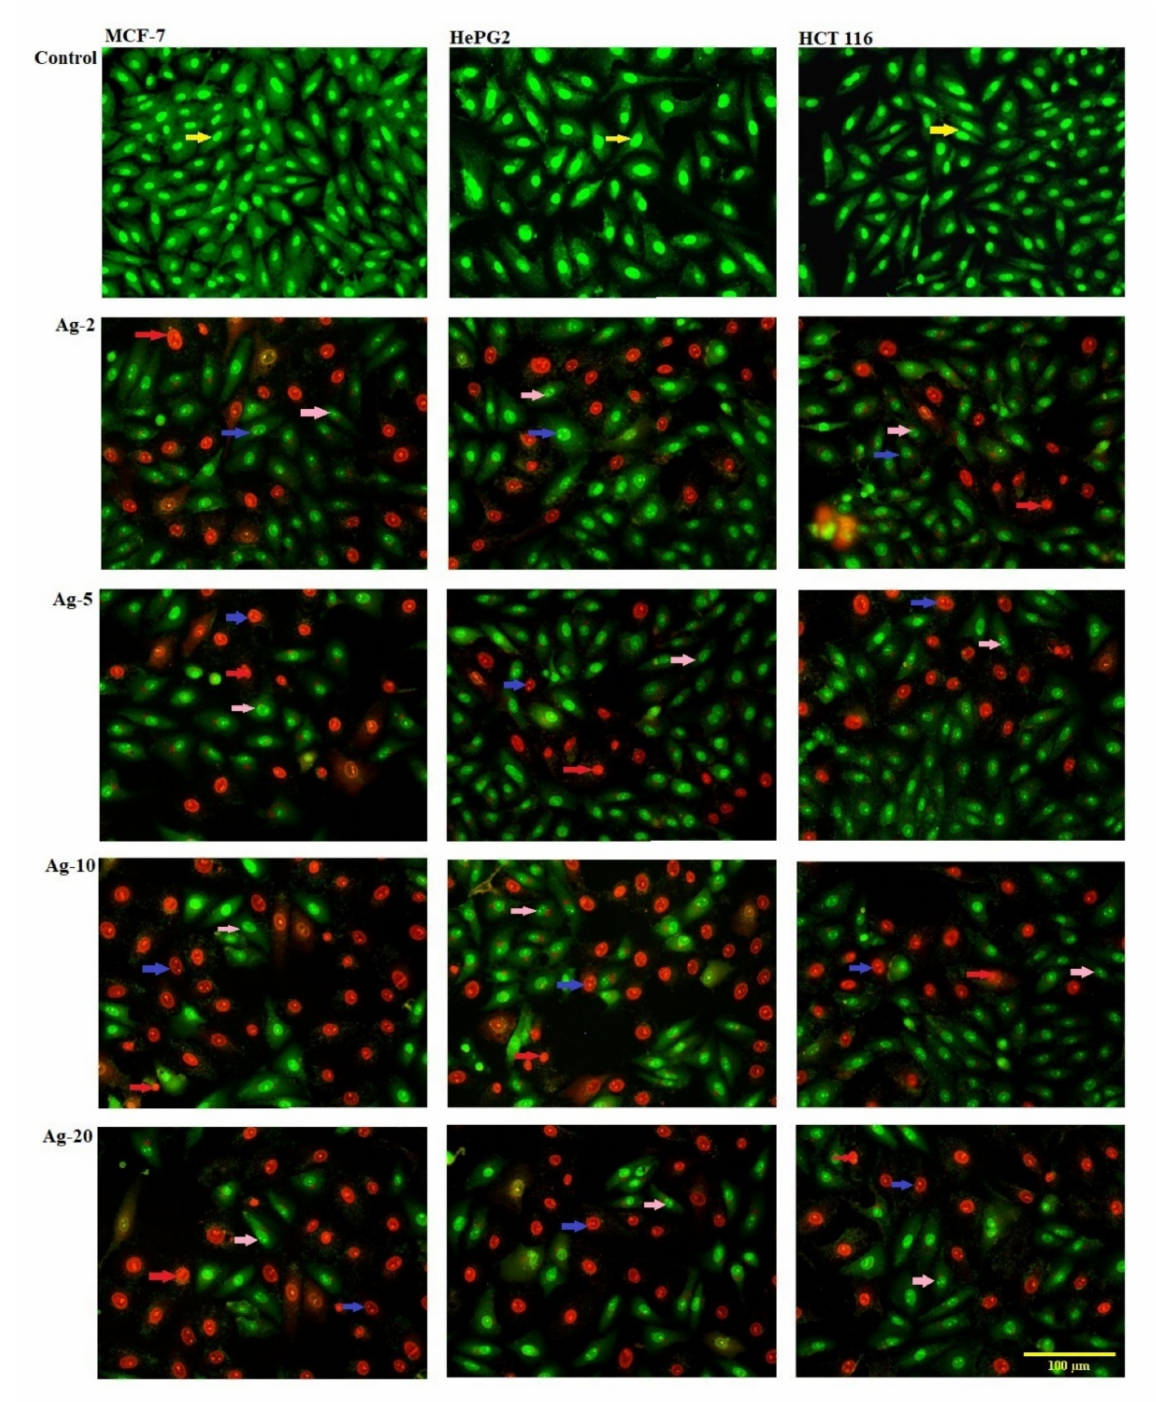
Figure 8. The effect of nanosilver compounds treatment on the apoptosis and necrosis of MCF-7, HepG2, and HCT 116 human tumor cells was evaluated using acridine orange (AO) and ethidium bromide (EB) staining after 48 h of treatment, inducing various nuclear changes such as chromatin fragmentation and condensation at 200 × . Yellow arrows indicate live cells, pink arrows indicate early apoptotic cells, red arrows indicate necrotic cells, and blue arrows indicate late apoptotic